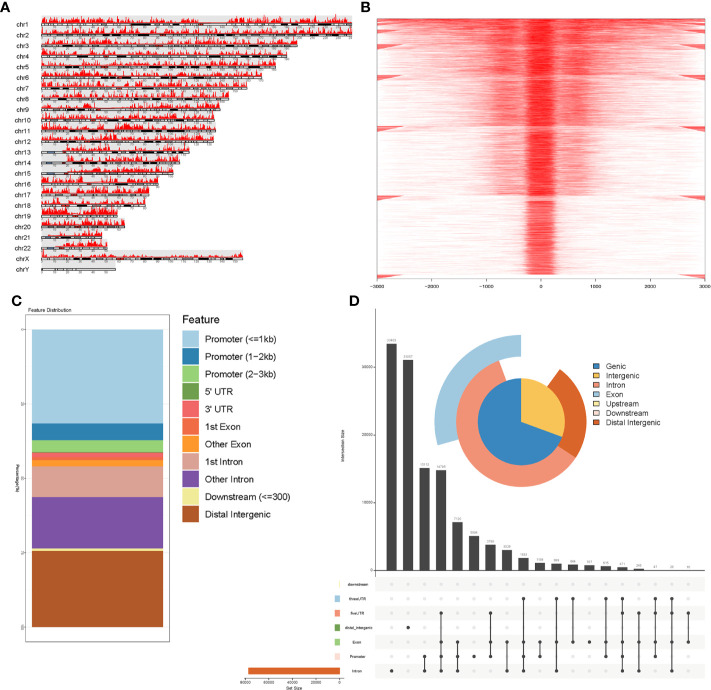
Identification of accessible chromatin in STADs using ATAC-seq analysis. (A) Peak calling function was performed to identify open chromatin regions. Visualization of peak regions over chromosomes revealed that chromatin accessibilities were widely present over the whole genome. (B) Peaks that could be mapped to the TSS regions were aligned to construct a tagMatrix. The majority of open chromatin regions were located around the TSS regions. (C) Annotation of chromatin accessibilities to the nearest genes indicated that most were located in the promoter regions. (D) Venn pie diagram and an upset plot indicated that most open chromatin regions were located in promoter and intronic regions.